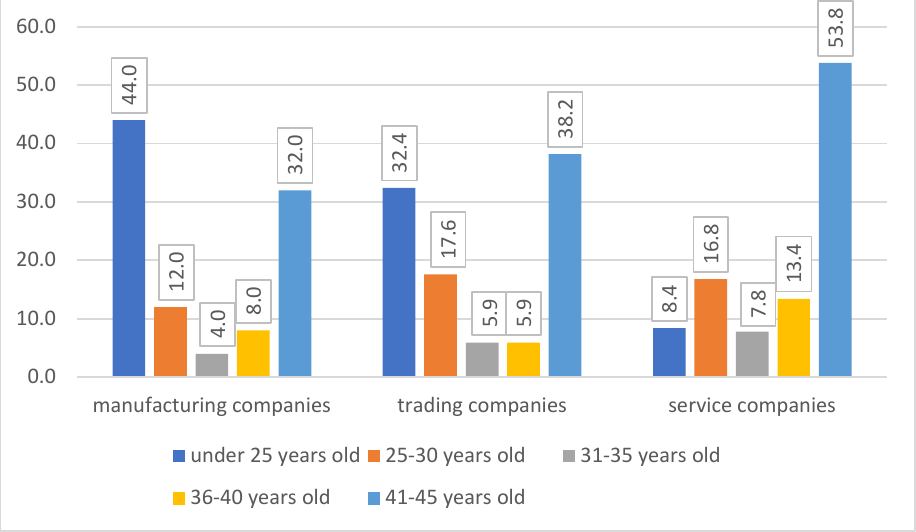
Figure 2. Respondents’ age (percentage) in different types of companies. Source: own elaboration based on the results of the study.